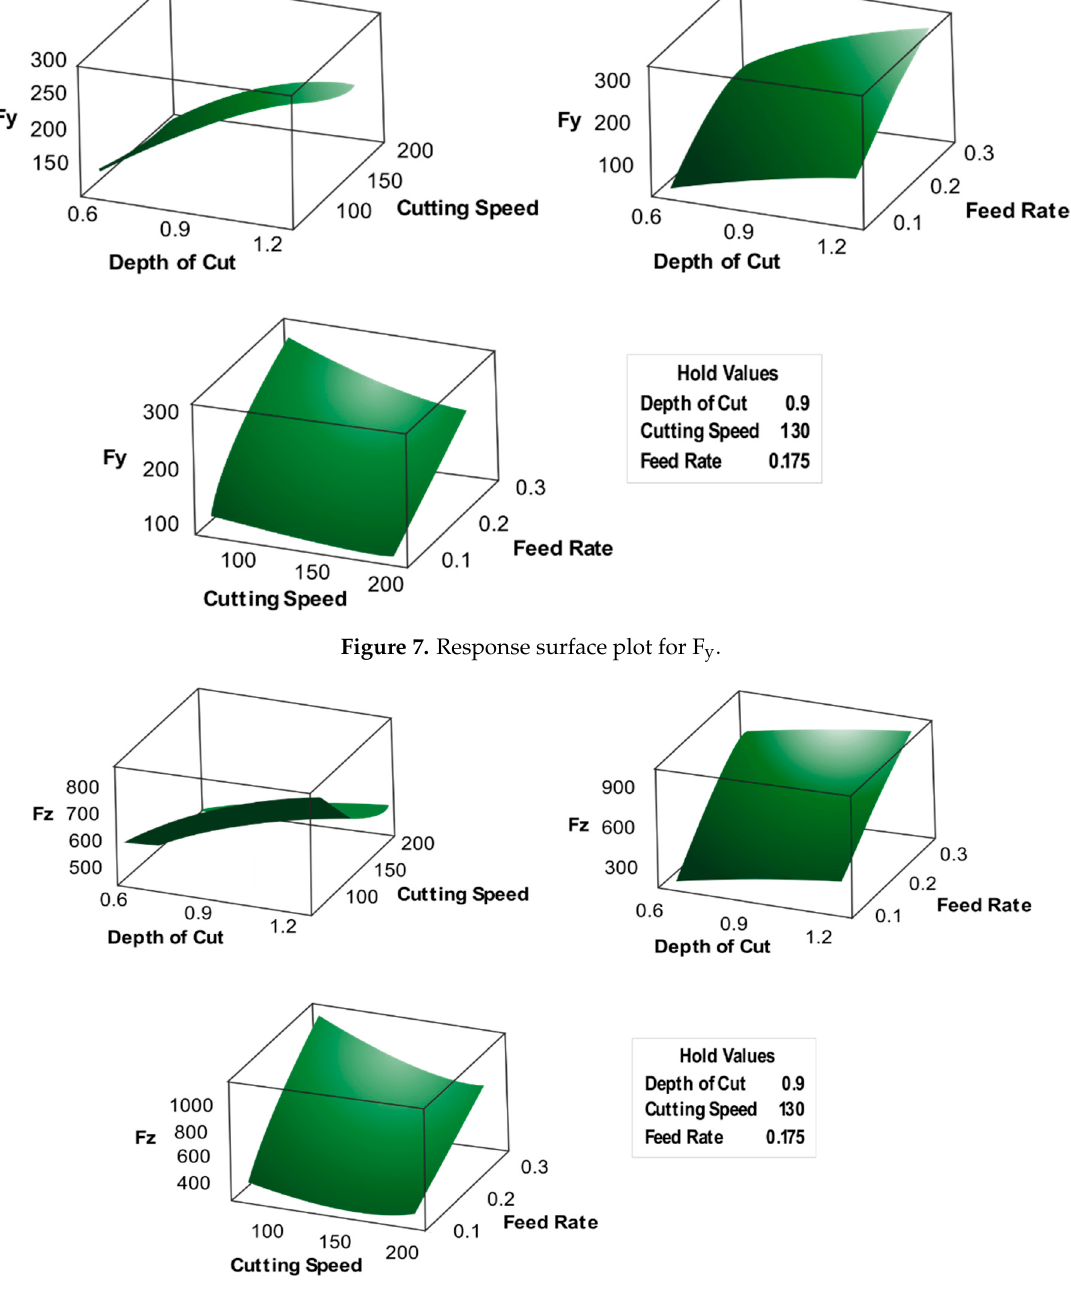
Figure 9. Response surface plot for surface roughness. 3.4. Effect of Input Parameters with Chip Formation The chip formation in the course of turning Al–Si–TiB 2 composite at 0.9 mm cut depth and varying cutting speed and feed are demonstrated in Figure 10. Chips were mostly discontinuous due to hard and brittle Al–Si matrix and ceramic reinforcement. With a discontinuous nature of chips, some variations in shape, size and thickness were also observed. The form of the chips generated at a cutting speed of 70 m/min was curly and short, and when cutting speed increased to 190 m/min the shape of chips became longer and curlier, as shown in Figure 10. If the chip thickness was high, the shear angle became small. This caused the cutting force and the energy required for deforming the material to increase, which means the smaller the chip thickness, the better the machinability will be. A typical machined surface of Al–12%Si/6wt.%TiB 2 composite is presented in Figure 11. High-